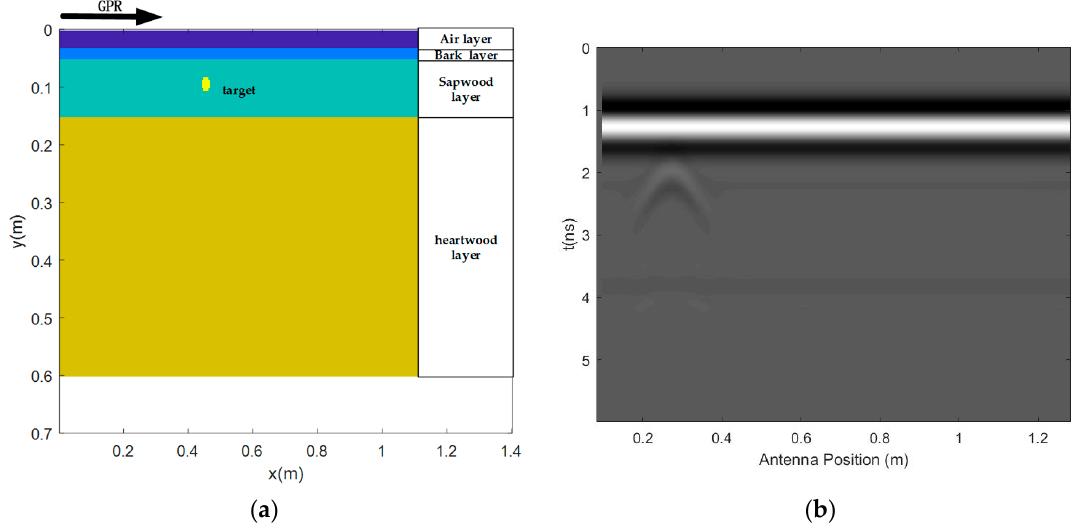
Table 1. Property parameters of chosen media in configuration.